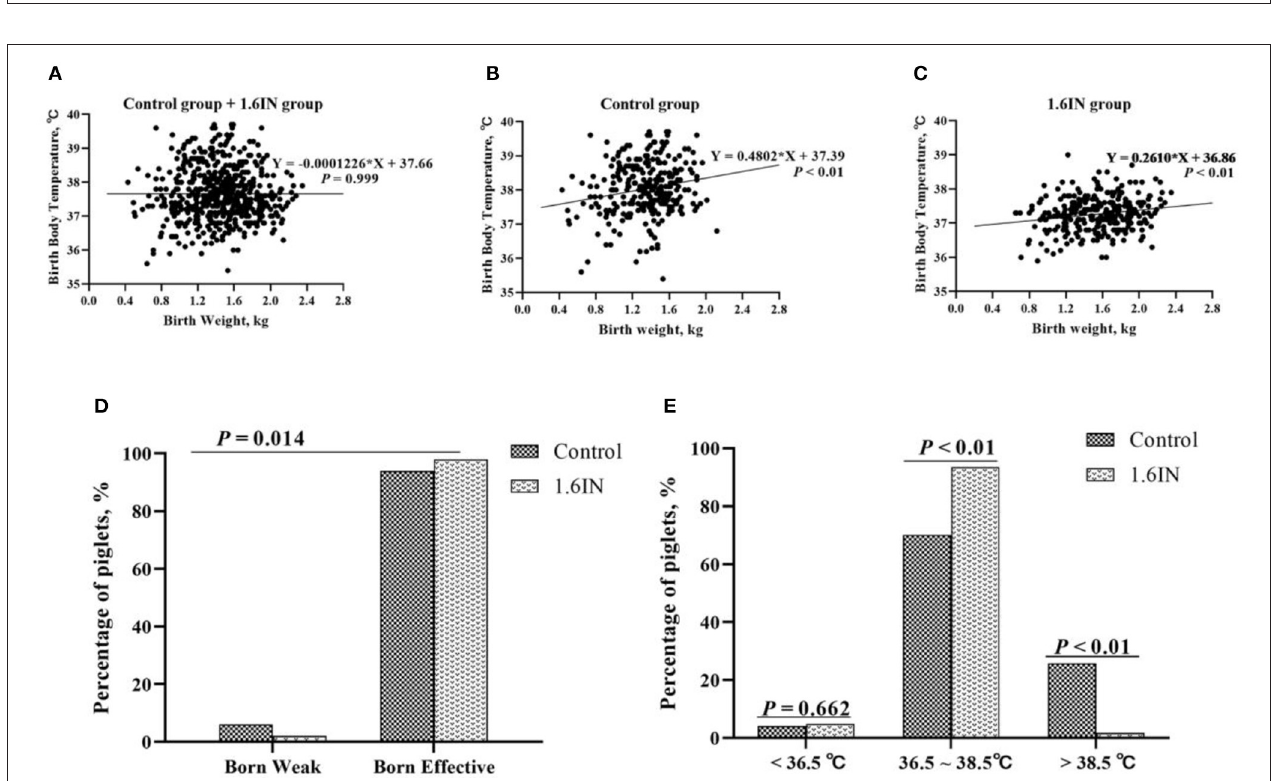
FIGURE 3 | (A–C) Relationship between birth weight and birth body temperature of piglets and (D,E) effects of dietary inulin on the birth weight and birth body temperature of newborn piglets. N = 295 and 291 for the control group and 1.6IN group, respectively. A Chi-square test was conducted to judge whether (D) low birth weight improved or (E) distribution of birth body temperature of newborn piglets changed.